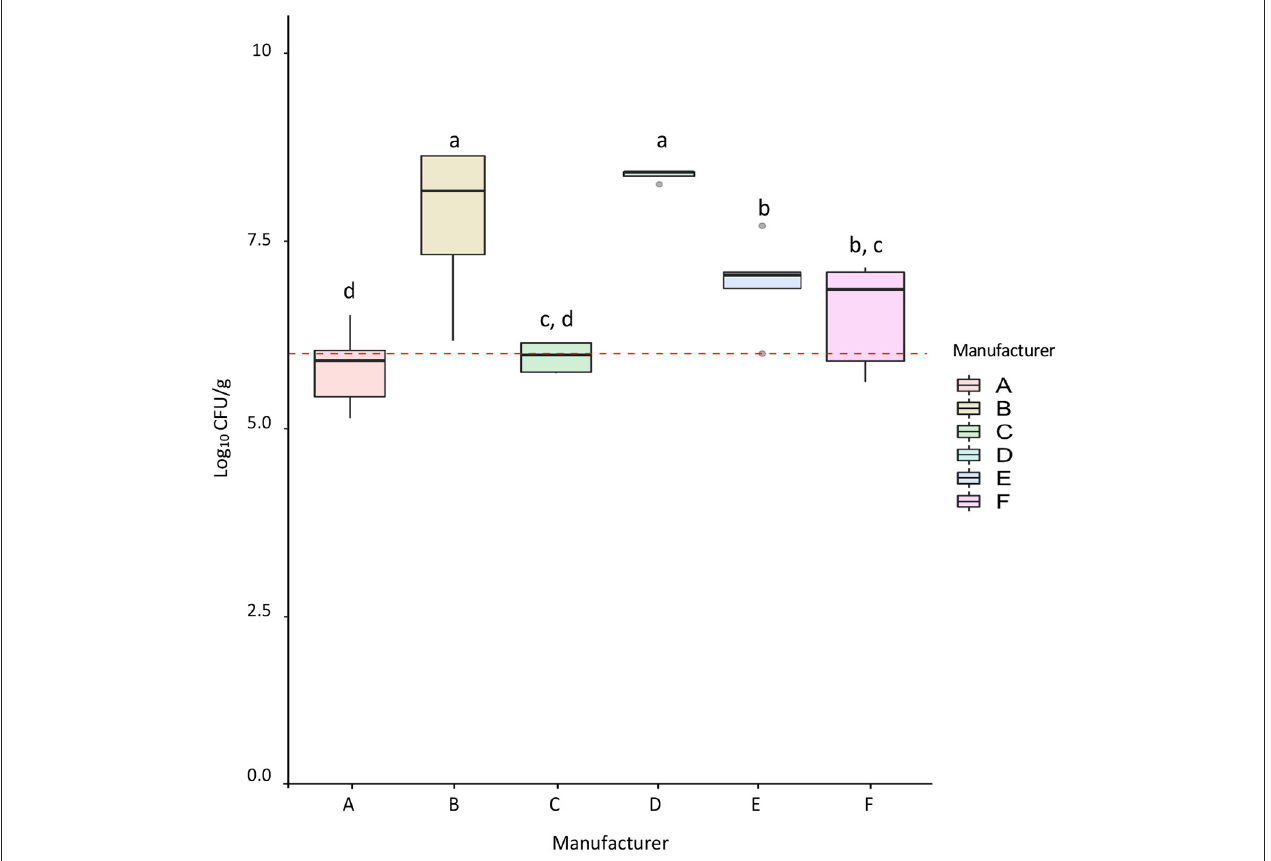
FIGURE 2 | Aerobic bacterial counts (APC) for commercial RMBDs from different manufacturers. The number of samples from each manufacturer was: A = 5, B = 4, C = 5, D = 5, E = 6, F = 6. The Fligner-Killeen test was used to determine the homogeneity of variances and the Shapiro-Wilk test for normality. Multiple comparison analysis of ANOVA for the APC was performed between manufacturers. Different letters marked for bars represent significant differences ( p -value < 0.05). The red line shows the suggested APC upper limit for animal compound feed according to Kukier et al. (19).